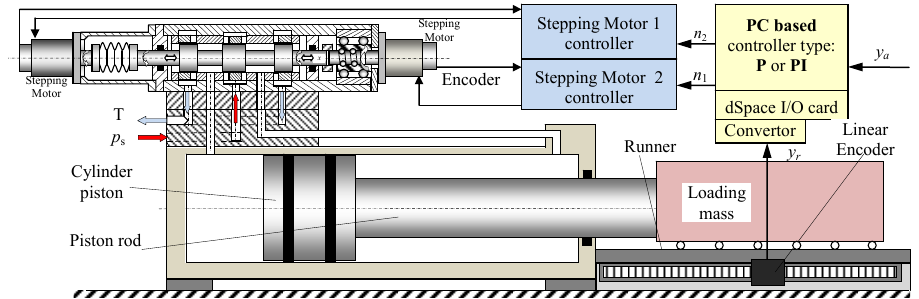
Figure 6. The scheme of electrohydraulic servo drive controlled by a valve with two stepping motors [29,30].